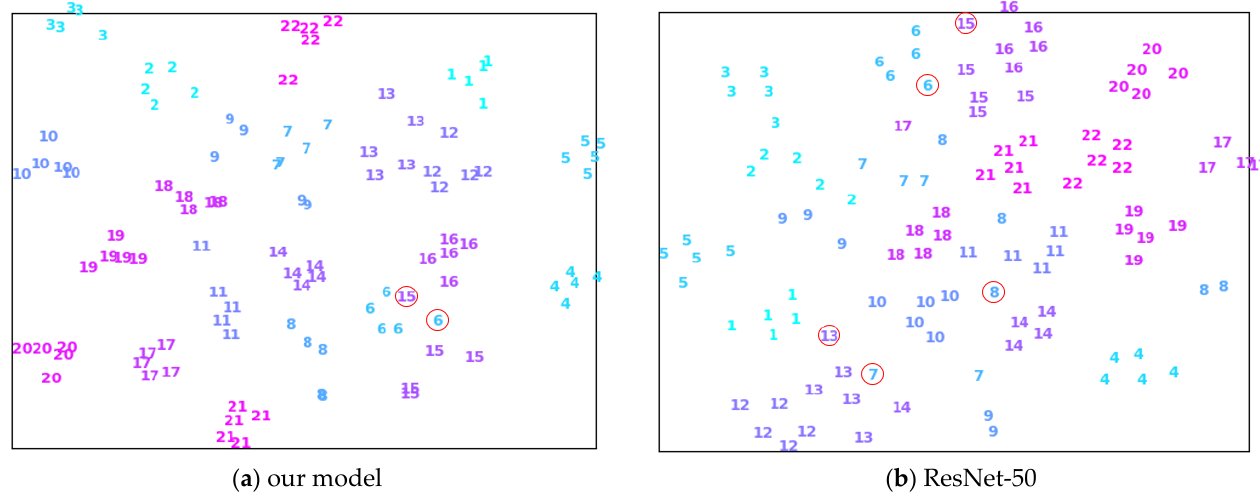
Figure 5. Visualization of different latent representations of mineral images with t-SNE. Five images for each kind of mineral are given. Misrecognized images are marked by red circles. ( a ) and ( b ) are t-SNE embedding based on our model and ResNet-50 with softmax loss, respectively.